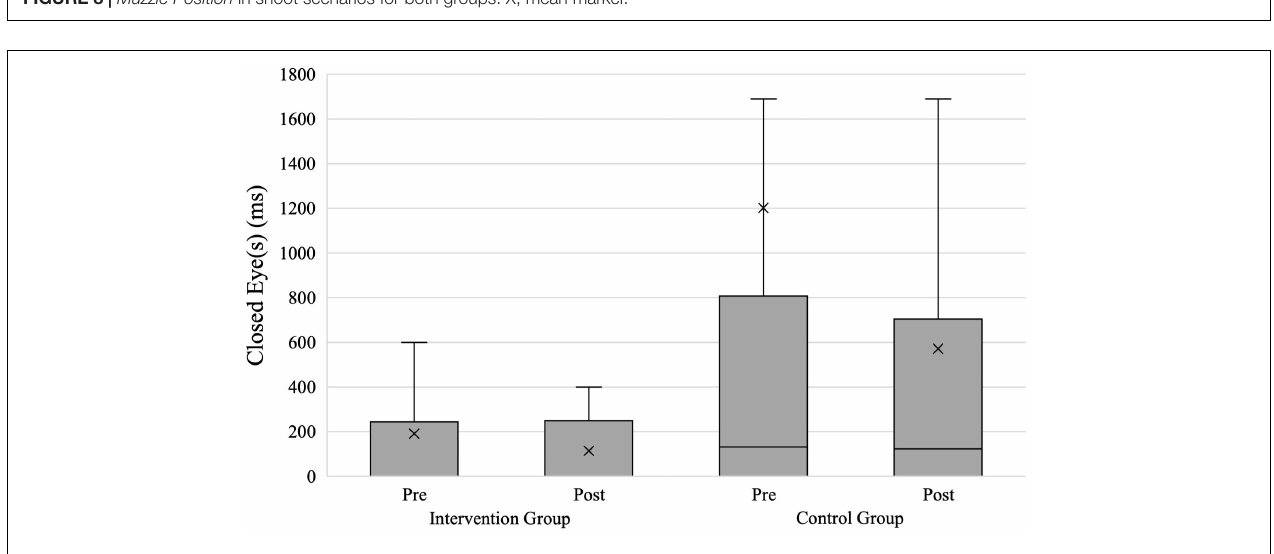
FIGURE 8 | Muzzle Position in shoot scenarios for both groups. X, mean marker.